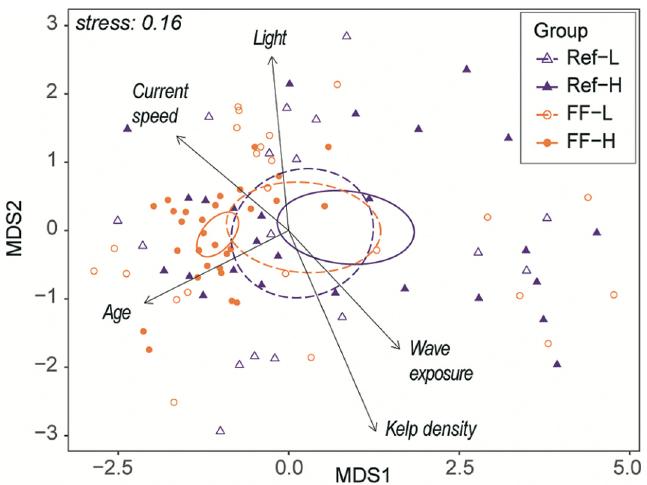
Fig. 7. NMDS of the epiphytic community on stipes of Lami- naria hyperborea kelp canopy plants collected at fish farm Ectocarpus spp. sites (low effluent levels: FF-L; high effluent levels: FF-H) and reference sites (Ref-L, Ref-H) in the Frøya (Ref-L, FF-L) and Smøla (Ref-H, FF-H) archipelagos, Norway. The NMDS was based on Bray-Curtis similarity matrix on square-root transformed biomass (g fresh weight standardized to 10 cm 2 ungrazed stipe) community data. Overlaid are vectors of sig- nificant environmental variables (including Site 7, see statis- tical analysis and Table S4) and 95% confidence ellipses around group centroids